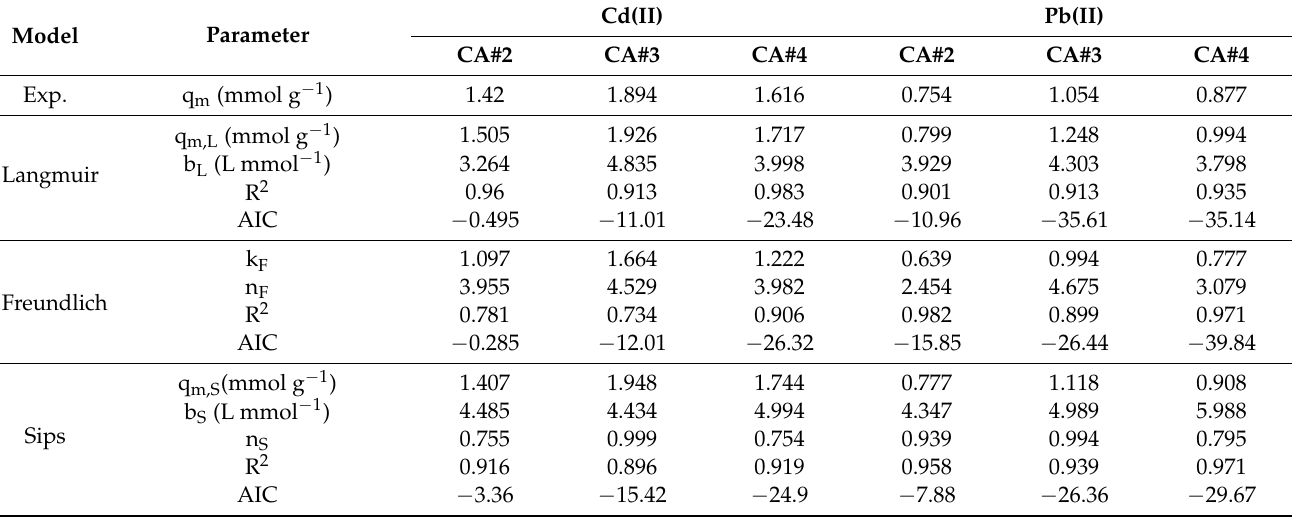
Table 2. Parameters of fitted models for Cd(II) sorption isotherms by using CA#2–4 sorbents.